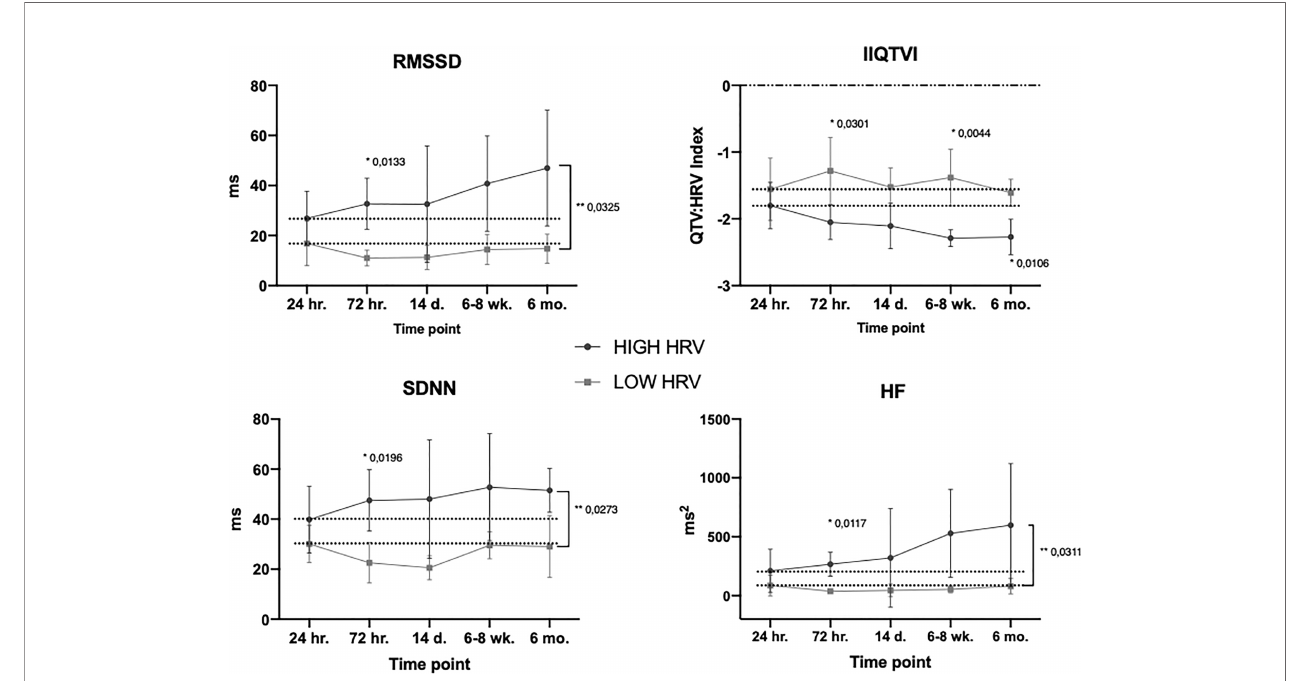
FIGURE 4 | Temporal HRV subgroup trajectories. Mean values, SD. Dotted line is level at start of ‘ response time ’ (24hr.). * Bonferroni ’ s multiple comparison test, ** Group x time effect (mixed effect model). For the variable IIQTVI – the more negative the value, the stronger the variability. For all timepoints, see Supplementary Figure 2 .